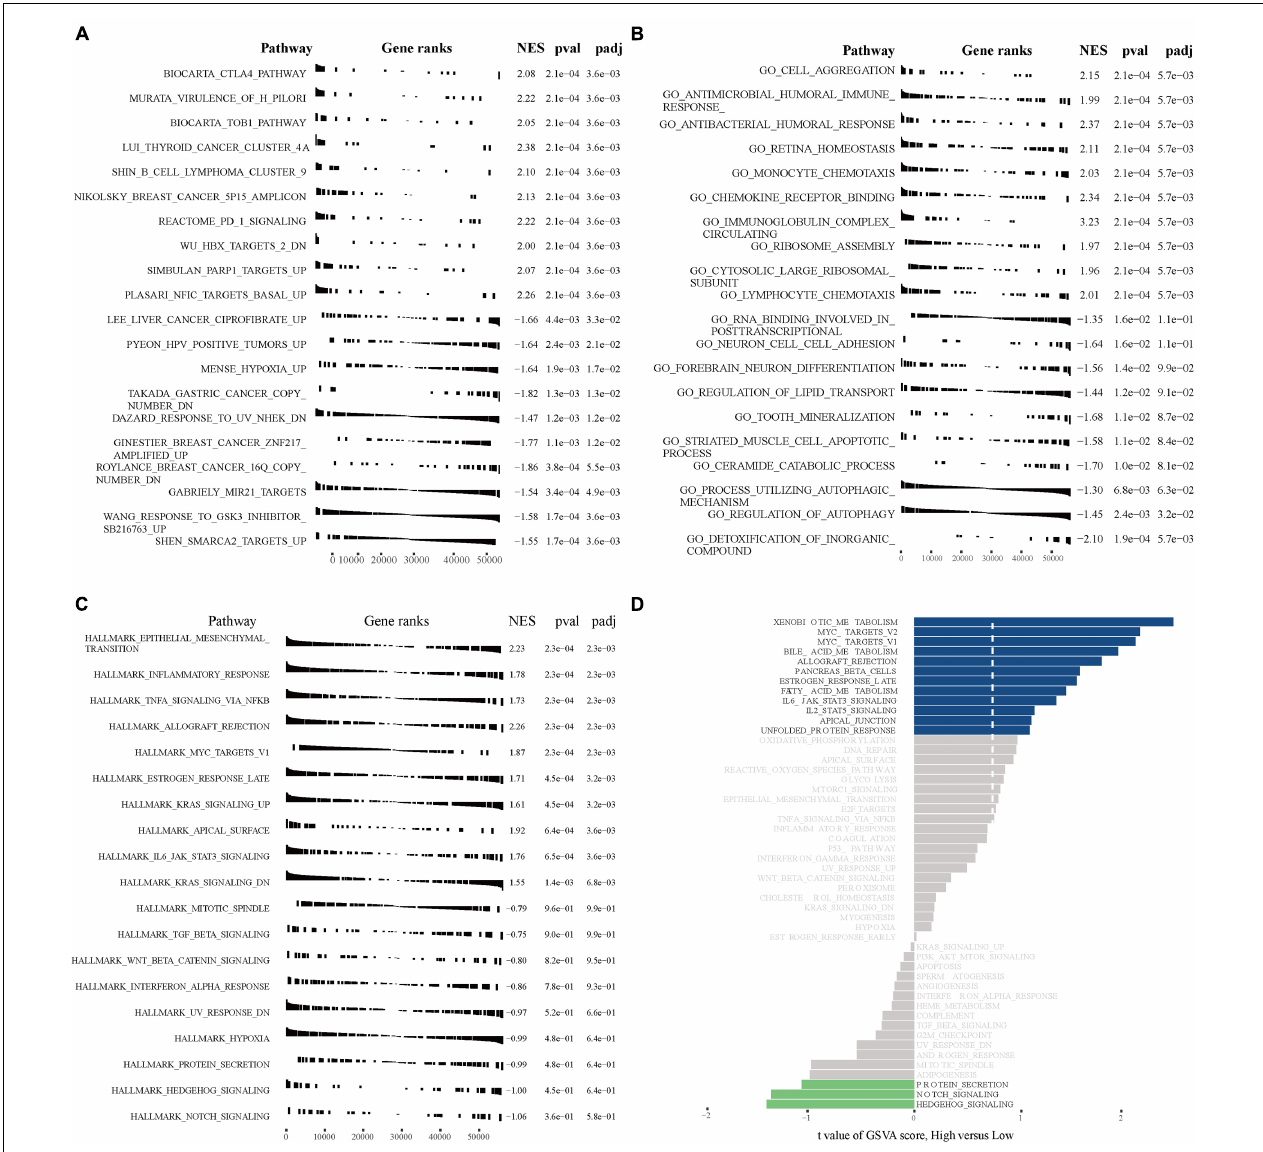
FIGURE 9 | GSEA and GSVA in high- and low-risk osteosarcoma patients. (A) GSEA analyses with “c2.all.v7.1.symbols.gmt” as the reference gene set. (B) GSEA analyses with “c5.all.v7.1.symbols.gmt” as the reference gene set. (C) GSEA analyses with “h.all.v7.1.symbols.gmt” as the reference gene set. (D) GSVA analyses with “h.all.v7.1.symbols.gmt” as the reference gene